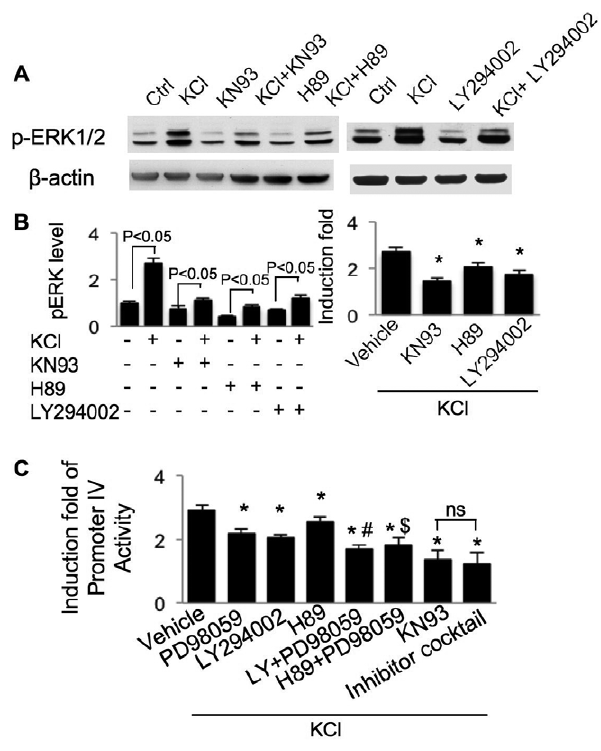
Figure 10. Crosstalk among calcium-stimulated protein kinases and the effects of simultaneous inhibition on promoter IV- mediated transcription. DIV 14 neurons were treated with KN93, or LY294002, or H89 for 30 min before the KCl (50 mM) stimulation. The level of phospho-ERK1/2 and b -actin were examined 20 min after the stimulation by Western blot (A). The signal of pERK1/2 was quantified and normalized to b -actin (B). In the right panel of B, the effects of protein kinase inhibitors on KCl-induced pERK1/2 up-regulation were normalized to the pERK1/2 level in neurons treated with inhibitor only (*: statistically different to that of KCl-stimulated pERK1/2 up-regulation in neurons not treated with protein kinase inhibitors). In C, neurons were transfected with PIV-Luc and TK-pRL on DIV 9. On DIV 11, neurons were first treated with PD98059 (PD), LY294002 (LY), H89, and KN93 individually, or a combination of PD + LY, PD + H89, and PD + LY + KN + H89 (Cocktail) for 30 minutes. Then neurons were stimulated with KCl along with CNQX and APV for 6 hours, and analyzed by luciferase assay. Another set of neurons receiving inhibitor treatment without KCl was used for normalization purposes. The relative up-regulation of PIV activity in neurons treated with KCl + inhibitor was normalized to the PIV-luciferase level in neurons treated with inhibitor only. *: statistically different to that of KCl-stimulated PIV activity in neurons not treated with any inhibitor. # : significant different to KCl-stimulated PIV activity in neurons treated with either PD or LY. $: significant different to KCl- stimulated PIV activity in neurons treated with either H89 or PD. ns: not significantly different. Data were collected from 4 independent preparations for each